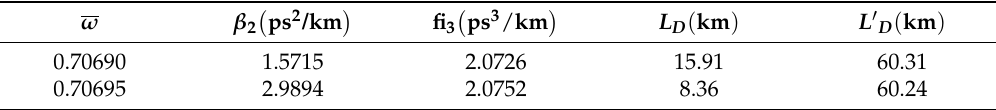
Table 2. Two sets of dispersion data for ω > ω D